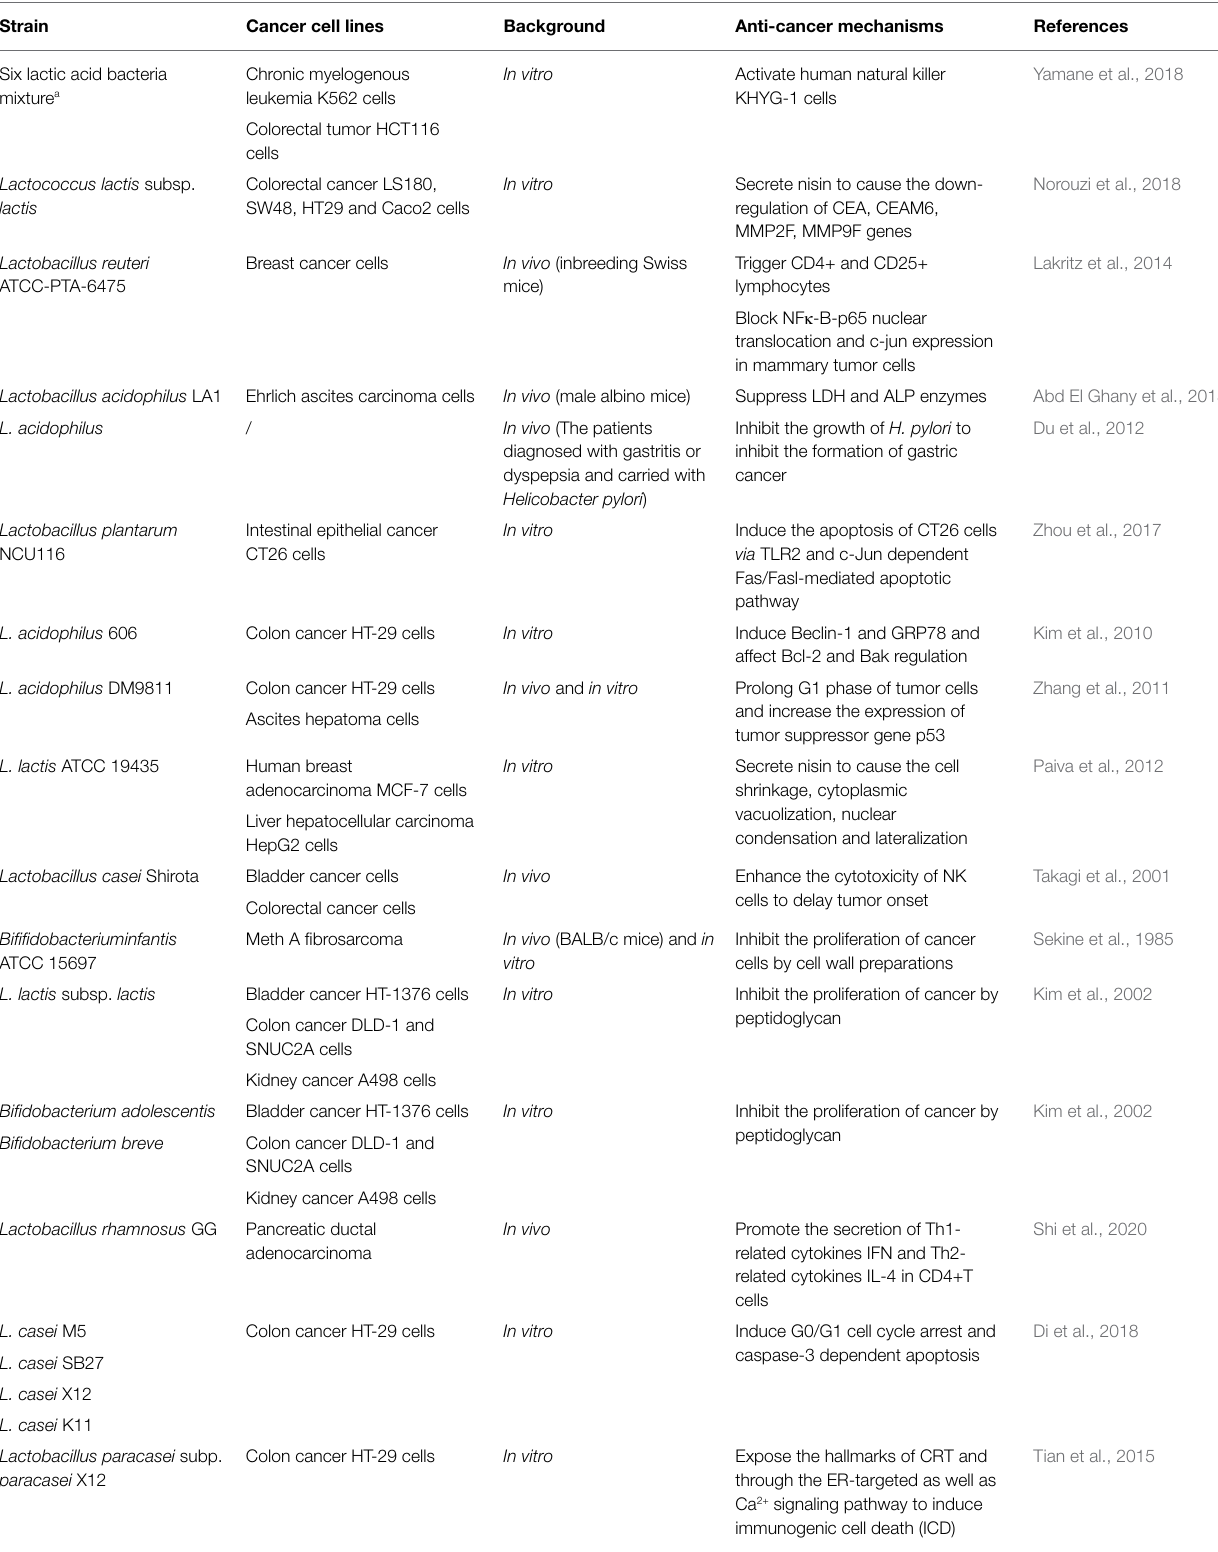
TABLE 1 | Lactic acid bacteria with potential anti-cancer